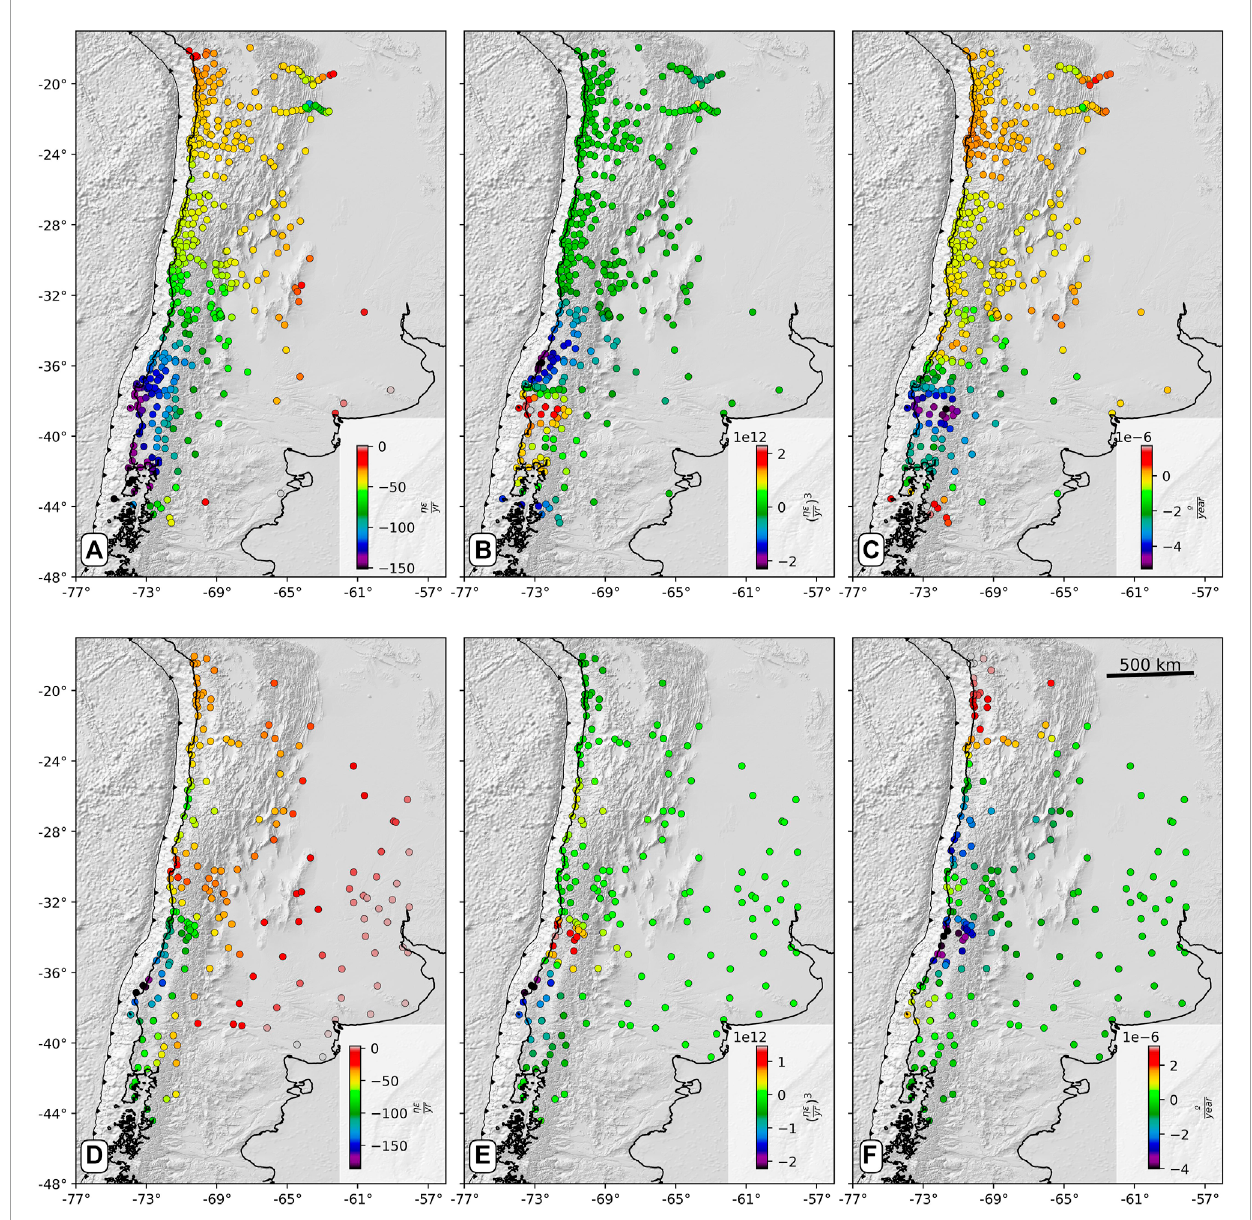
FIGURE 6 Features value. Pre-2014 I 1 (A) , pre-2014 I 3 (B) and pre-2014 w z (C) , 2018–2021 I 1 (D) , 2018–2021 I 3 (E) and 2018–2021 w z (F) .